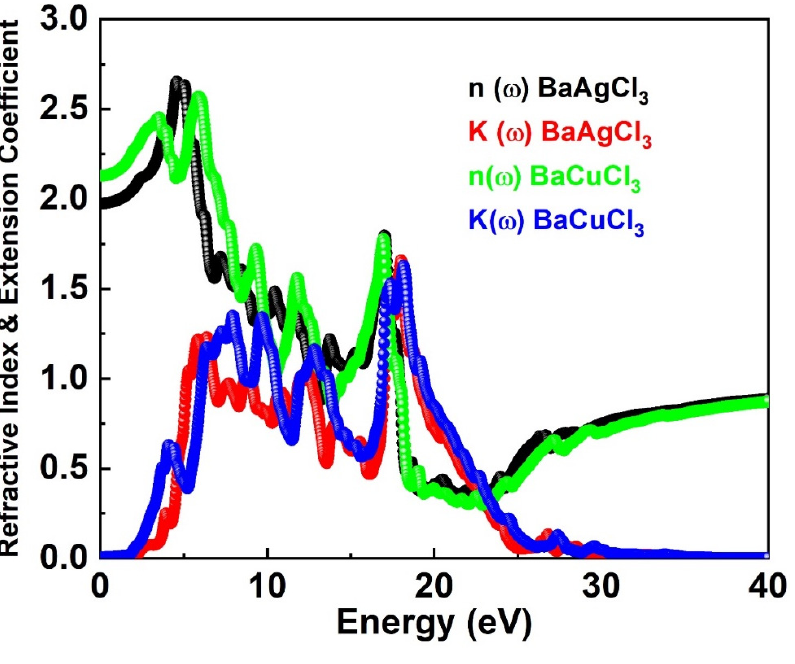
Figure 7. The refractive index and extension coefficient of ternary BaAgCl 3 and BaCuCl 3 chloroper- ovskites compounds.